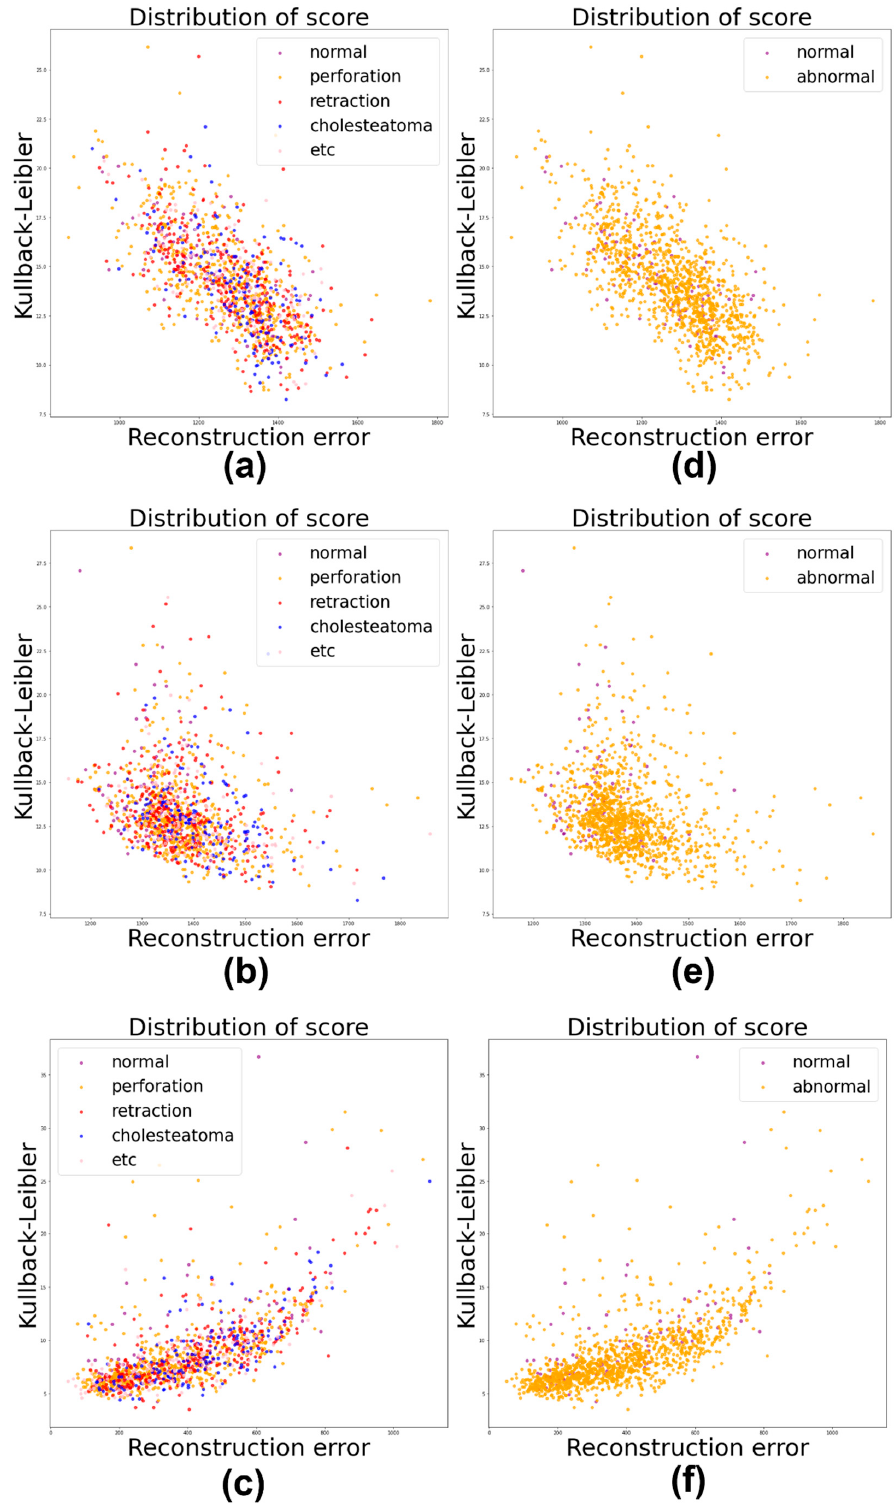
Figure 11. Distribution of abnormality scores: ( a , d ) are the original data; ( b , e ) are data after adaptive histogram equalization; and ( c , f ) are data after Canny edge detection. ( a – c ) are distributions for five classes: normal, performance, retraction, cholesteatoma, and classes that specialists struggle to classify as a particular disease but are certainly abnormal; and ( d – f ) are the distributions of